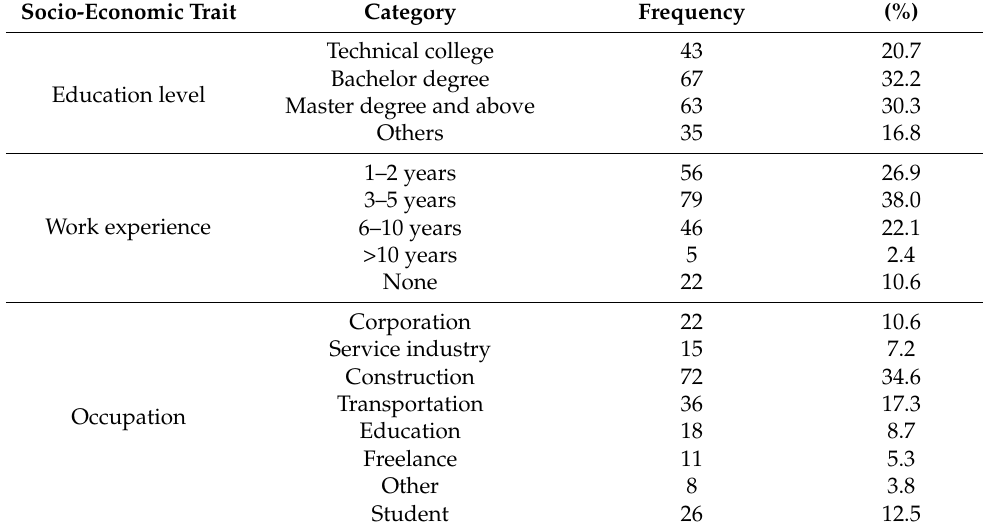
Table 3. Key socio-economic traits of the questionnaire respondents.